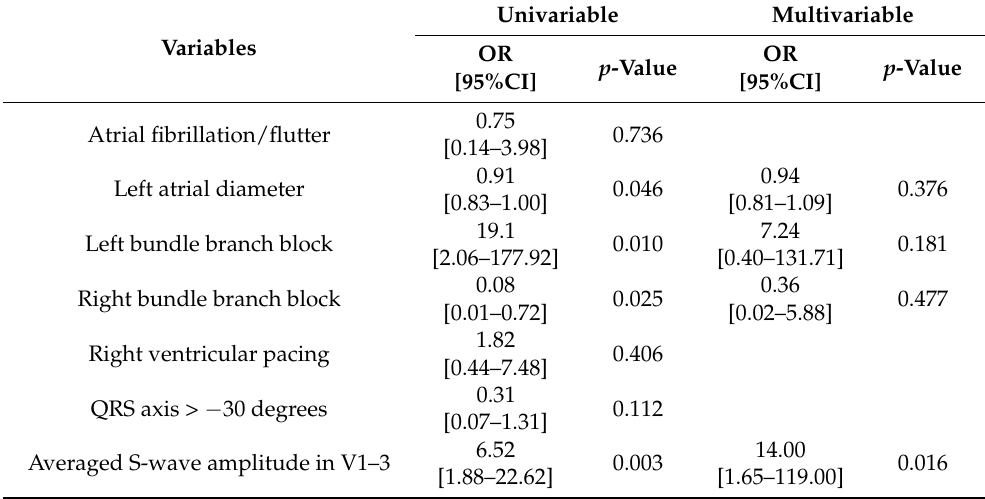
Table 2. Logistic regression analyses of a reduction in MR.